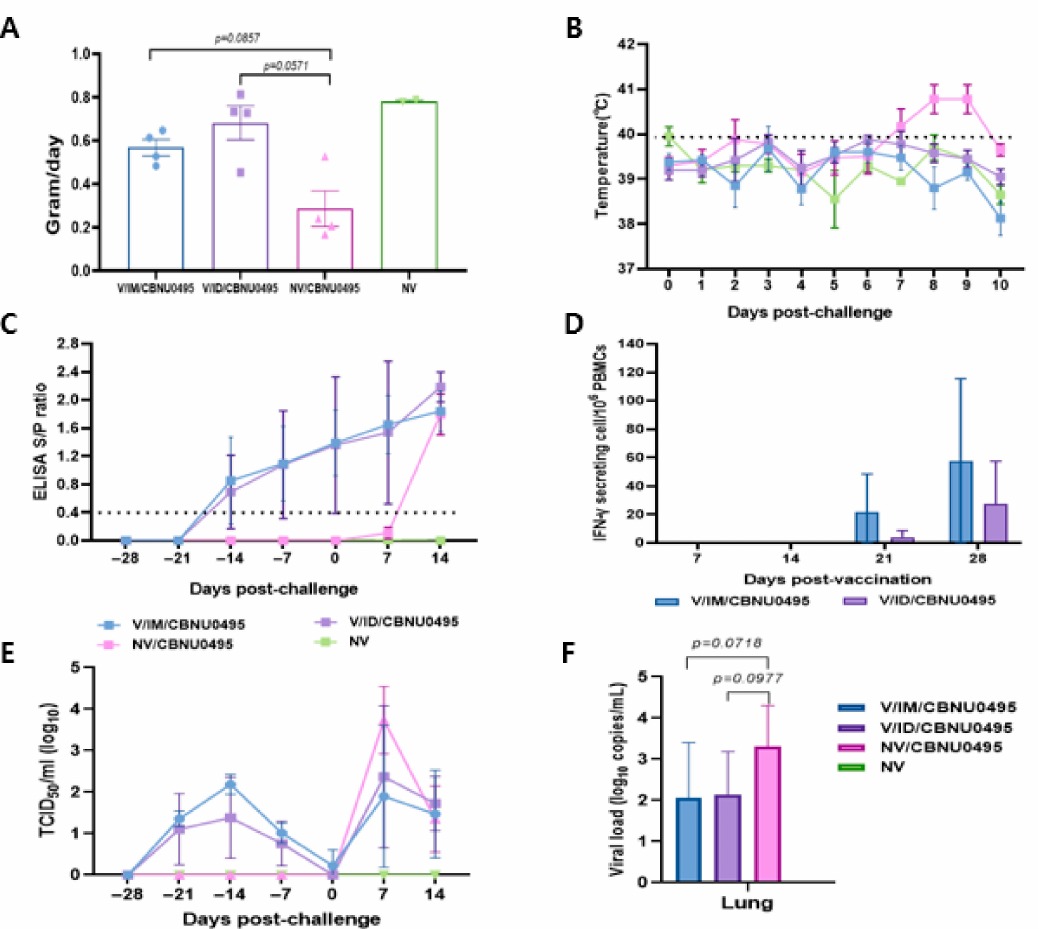
Figure 5. Induction of protective immunity by E38-ORF7 CPD. A group of 3-week-old pigs were vac- cinated with E38-ORF7 CPD via intramuscular and intradermal routes. At 4 weeks post-vaccination animals were challenged with 3 mL of 10 5 TCID 50 / mL heterologous virus (CBNU0495). Unvac- cinated challenged and unchallenged groups were maintained as control groups. Clinical signs, rectal temperatures, average daily weight gain, serum antibody level, and IFN- γ were